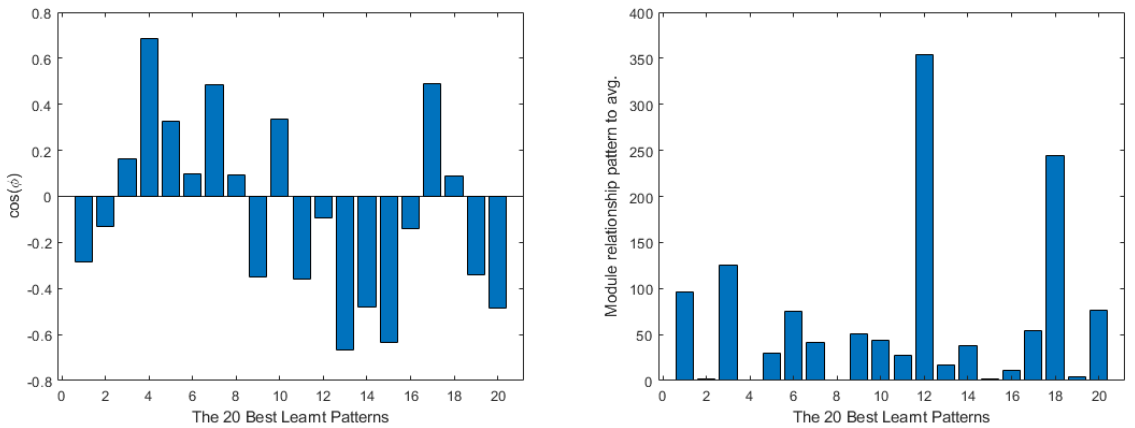
(cid:12) (cid:12) 𝜕𝐿𝑜𝑠𝑠 ∂ Loss (cid:12) (cid:12) | relationship to the average (cid:12) (cid:12) relationship to the average ∂ W n 𝜕𝑊 𝑛